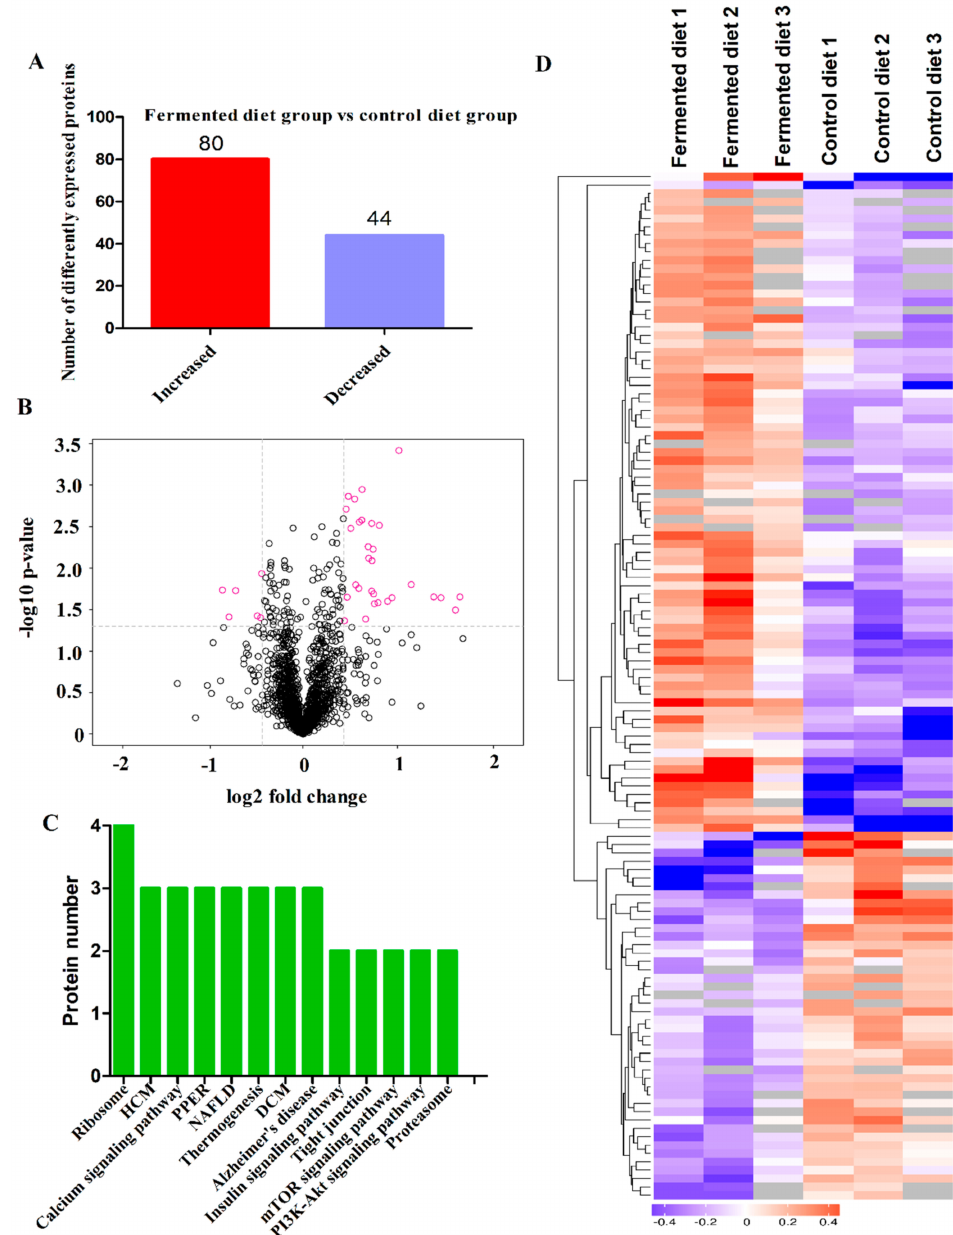
Figure 2. Statistical analysis of di ff erentially expressed proteins in pigs fed the fermented diet compared with those fed the control diet. ( A ) The classification of di ff erentially expressed proteins. ( B ) Volcano plots of identified proteins in pigs fed fermented diet compared with control diet; the red circles were the proteins that exhibited a di ff erential expression pattern in pigs fed the fermented diet compared with those fed the control diet. Black represented no significant change in expression level. ( C ) Clustering analysis of the proteins di ff erentially expressed between pigs fed the fermented diet and the control diet. Red and blue colored bars showed increased and decreased proteins, respectively. ( D ) The top 15 terms of Genes and Genomes (KEGG) pathway for di ff erentially expressed proteins (DEPs) in pigs fed the fermented diet and the control diet. DCM, dilated cardiomyopathy; HCM, hypertrophic cardiomyopathy; NAFLD, non-alcoholic fatty liver disease; PPER, protein processing in endoplasmic